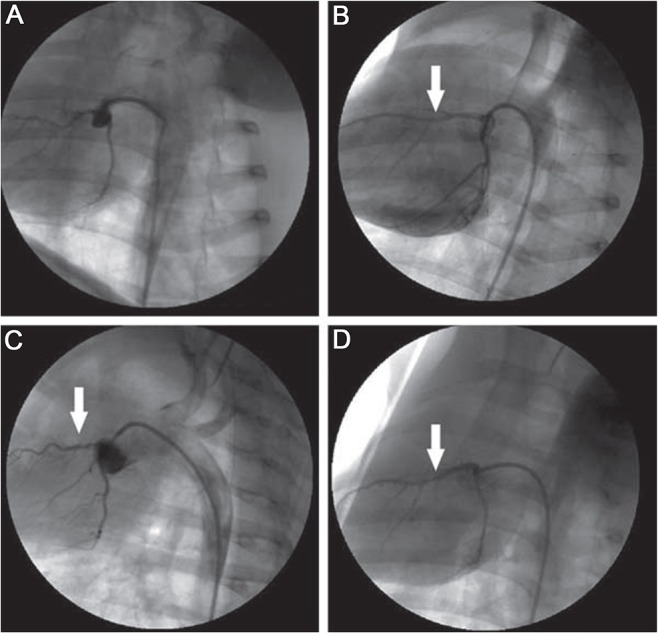
Coronary artery angiogram after left anterior descending (LAD) artery ligation.(A) Normal coronary artery in the sham-operated group. (A) Mild stenosis in LAD artery; the arrow indicates about 30% stenosis in the proximal LAD artery. (C) Moderate stenosis in the LAD artery; the arrow indicates about 60% stenosis in the proximal LAD artery. (d) Severe stenosis in the LAD artery; the arrow indicates about 80% stenosis in the proximal LAD artery. Arrows show the location of stenosis.